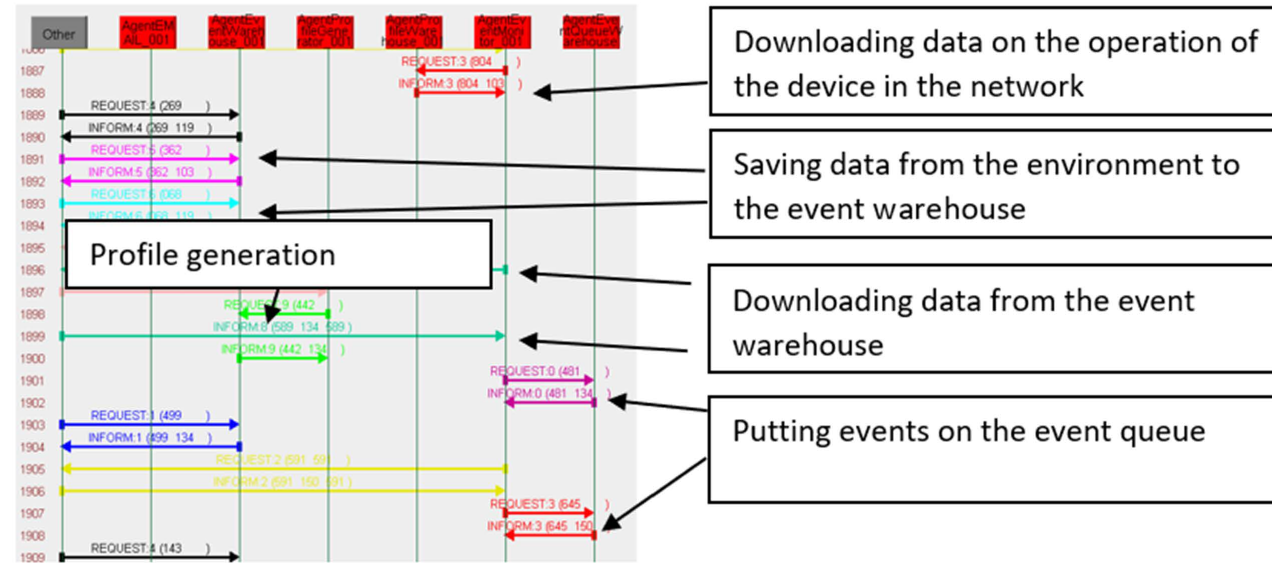
Figure 6. JADE platform at